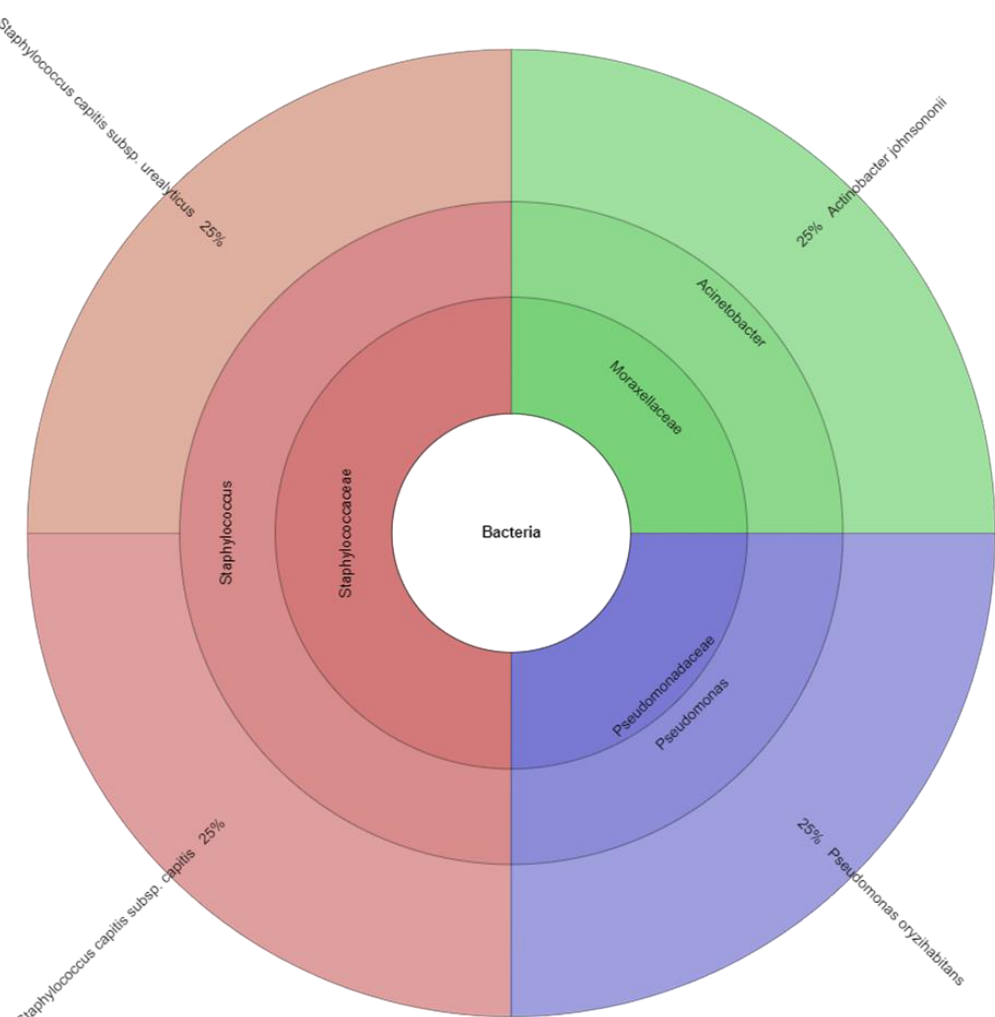
Figure 2. Krona chart: Isolated species of bacteria from marinated roasted products. The microbiota of chicken breast and thigh fillets at the end of storage was domi- nated by Proteobacteria and followed by Firmicutes [74], which is similar to findings of the current study. Genera Acinetobacter , Photobacterium , Pseudomonas , and members of Vibrionaceae family were found in raw meat. Pseudomonas was recognized as a predomi- nant psychotropic meat spoiler [75–81]. Pseudomonas were found only at high abundances (33.0%) on fresh thigh fillets. Acinetobacter , which belongs to the Moraxellaceae family, was detected on most chicken samples despite the observed differences in detection